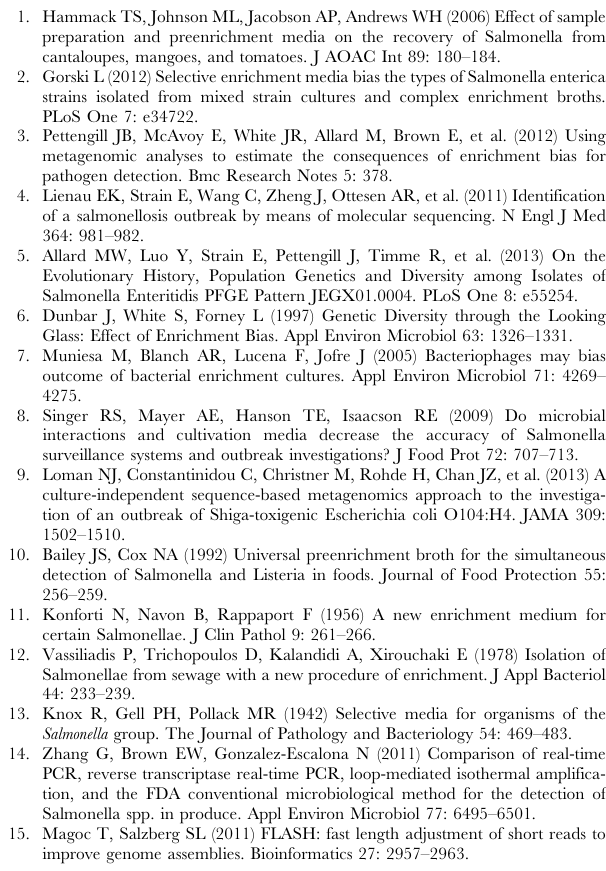
Table of Contents. 28. Mande SS, Mohammed MH, Ghosh TS (2012) Classification of metagenomic sequences: methods and challenges. Brief Bioinform 13: 669–681. 29. Luo C, Tsementzi D, Kyrpides N, Read T, Konstantinidis KT (2012) Direct comparisons of Illumina vs. Roche 454 sequencing technologies on the same microbial community DNA sample. PLoS One 7: